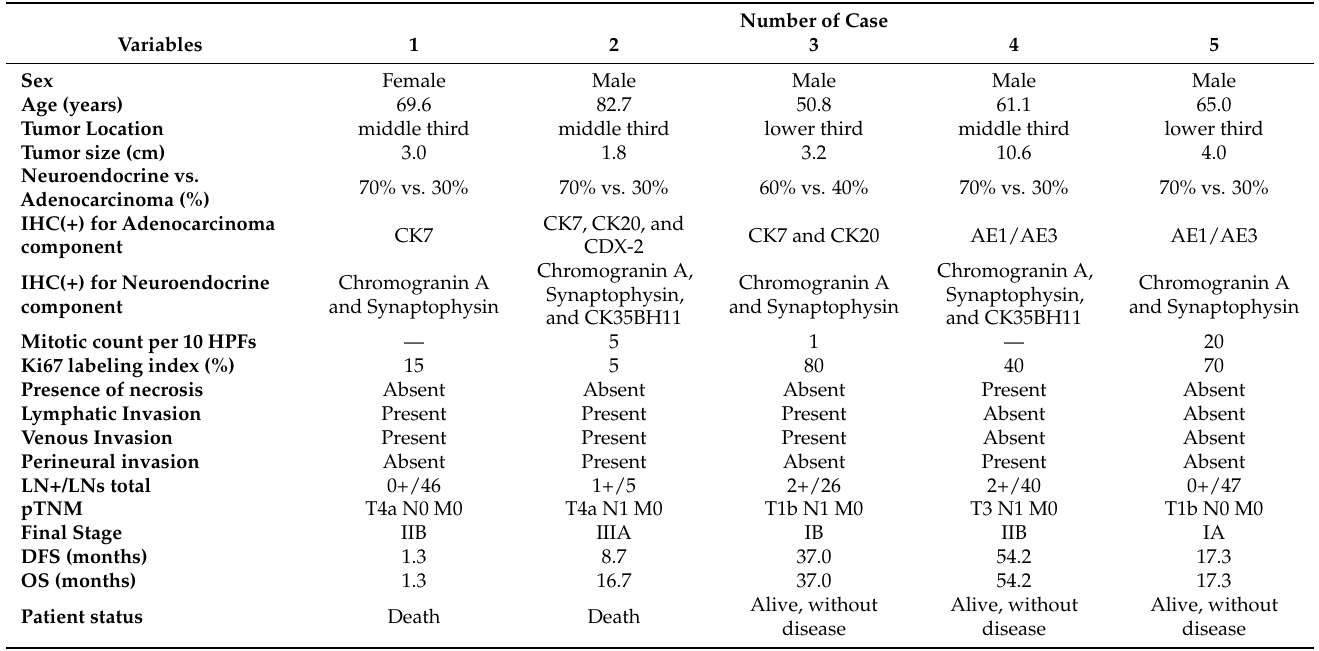
Figure 2. ( a,b ) Upper digestive endoscopy demonstrating gastric lesions compatible with MiNEN in one patient ( a ) the hyperemic surface of the MiNEN, associated with a central depression; ( b ) chromoendoscopy with magnification showing visible subepithelial capillaries; ( c ) CT scan showing gastric MiNEN in the gastric body of a patient. Table 3. Clinicopathological characteristics, surgical and oncological outcomes of the five MiNEN patients included in the